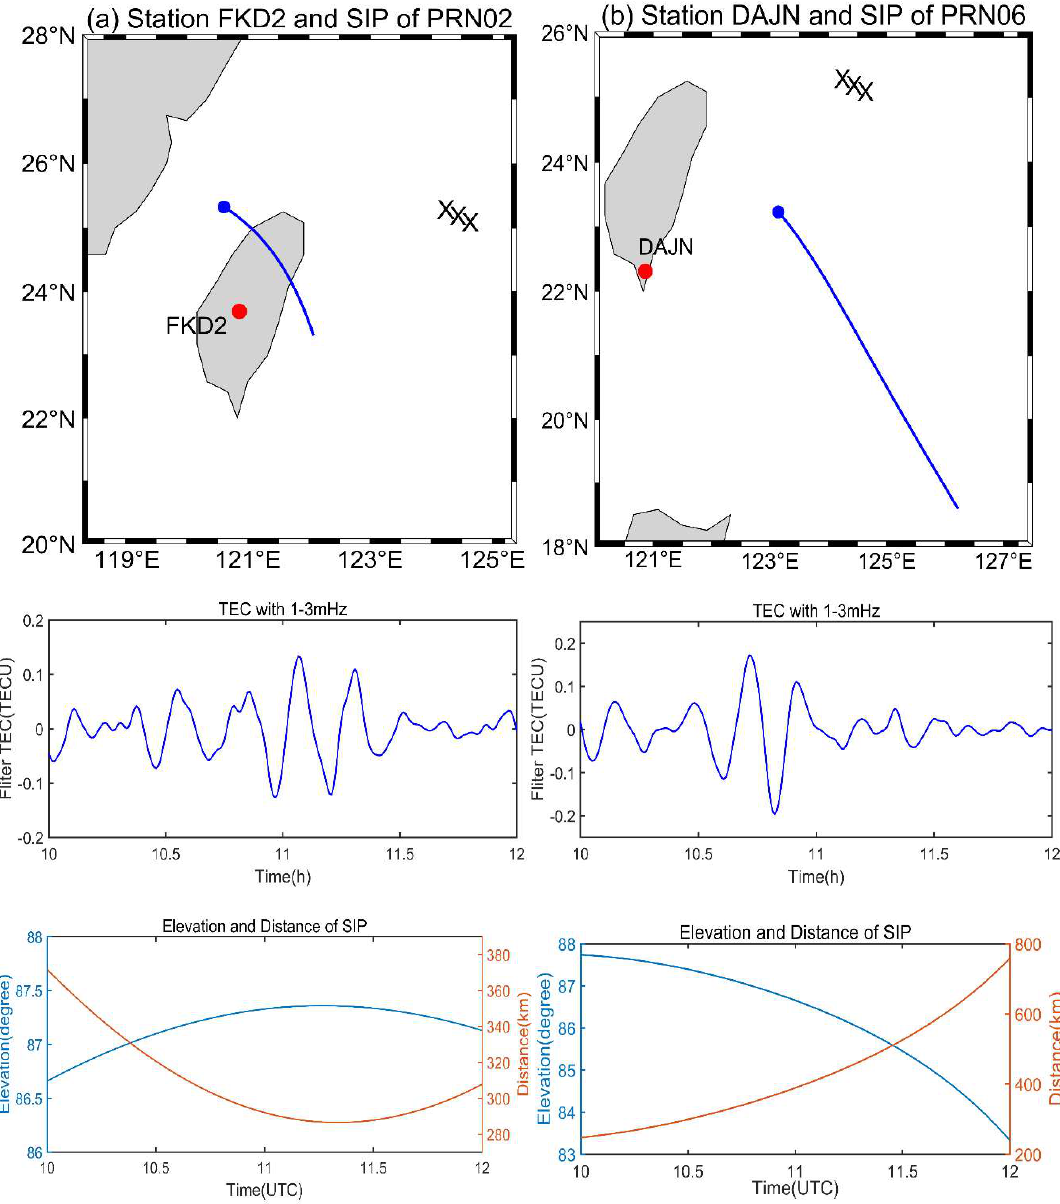
Figure 5. The tracks of the SIP observed by ( a ) satellite PRN02 at station FKD2 and ( b ) satellite PRN06 at station DAJN during the period 10:00-12:00 UTC in the upper panel, the filtered TEC time series diagram of the two stations is shown in ( c , d ) in the middle panel, and the change of elevation angle and distance between the typhoon eyes and the SIP is shown in ( e , f ) in the bottom panel.